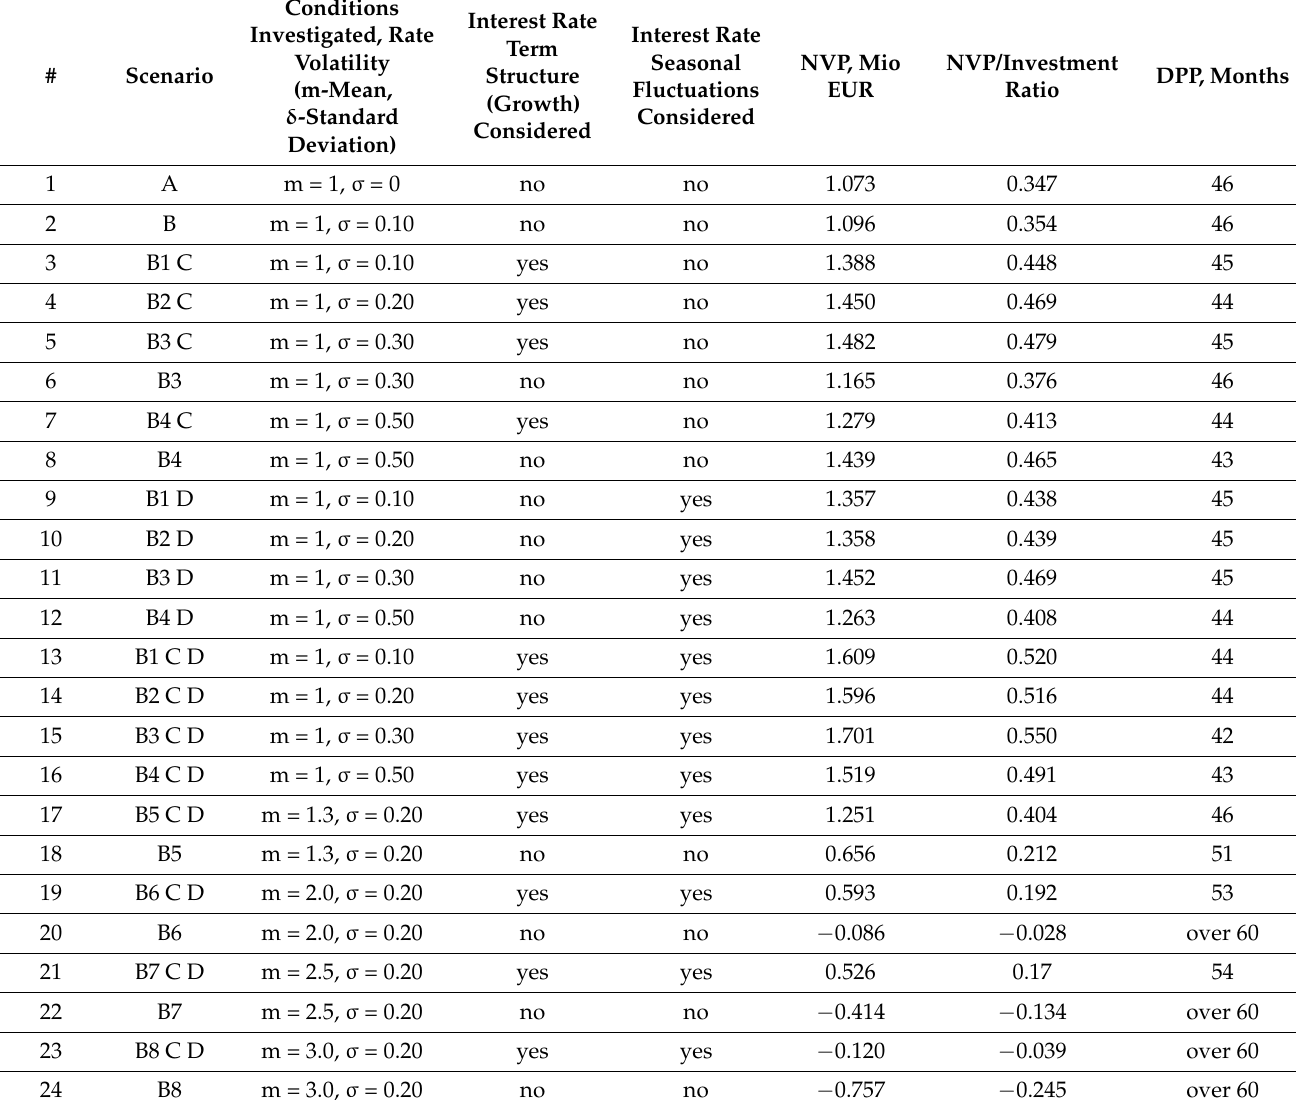
Table 5. Numeric results for different RADR